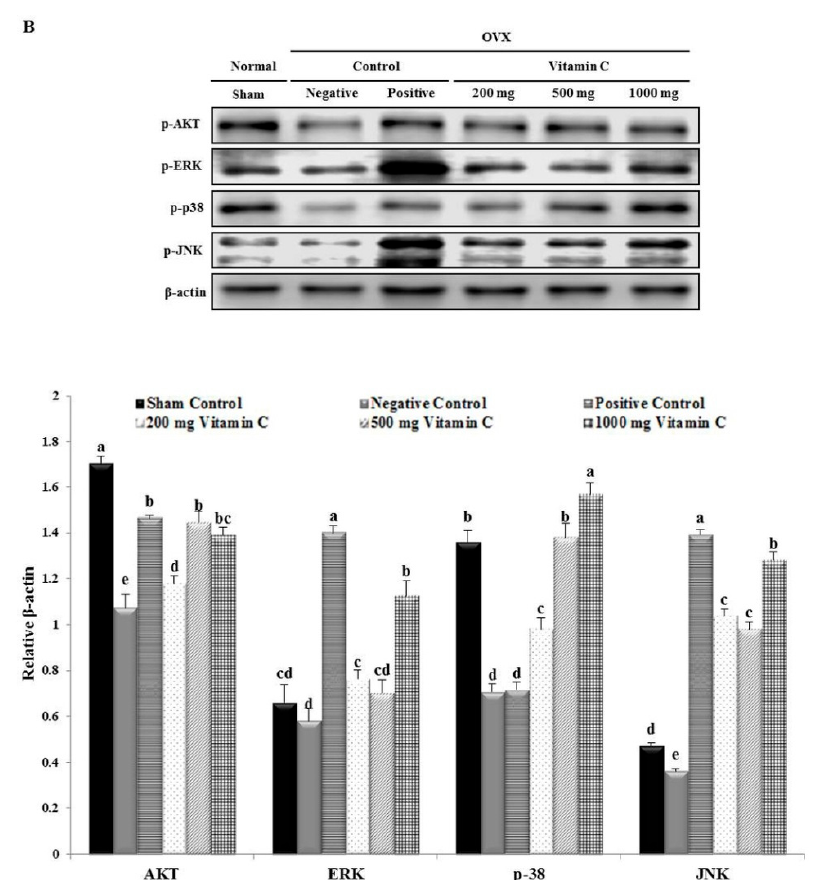
Figure 7. Expression of both osteoblast- and osteoclast-regulated proteins in vitamin C-treated rat tibias. ( A ) Western blot image of Wnt3a, β -catenin, and ATF4 and quantitative assay of Wnt3a, β -catenin, and ATF4 protein expression in vitamin C-treated rat tibias. ( B ) Western blot image of p-AKT, p-ERK, p-p38, and p-JNK and quantitative assay of p-AKT, p-ERK, p-p38, and p-JNK protein expression in vitamin C-treated rat tibias. Expression was quantified using ImageJ software relative to that of β -actin. Values represent the mean ± standard deviation. Values with different letters were significantly different according to Duncan’s multiple range test ( P < 0.05).